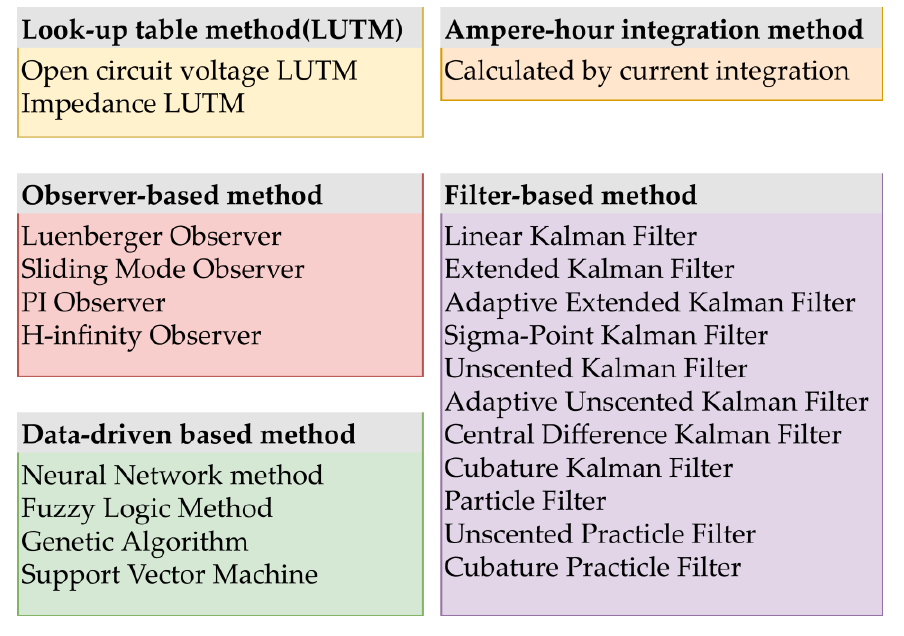
Figure 16. Different SOC estimation approaches.